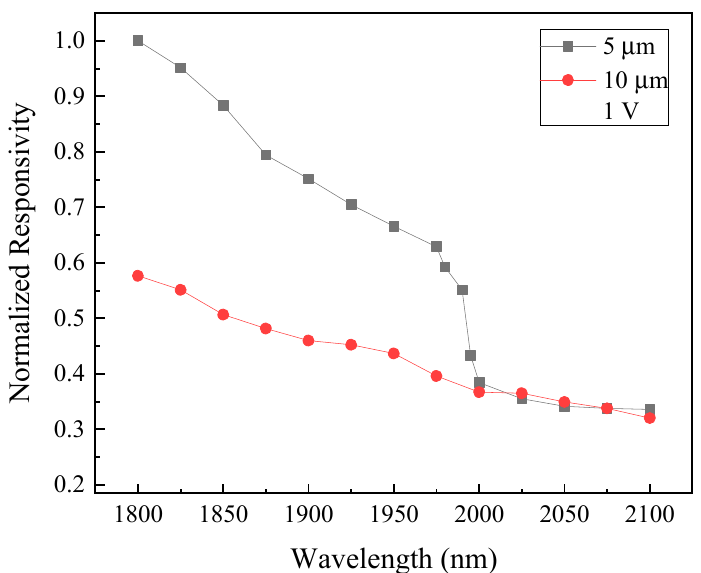
Figure 18. The normalized spectral responsivity of the GeSn MSM photodetector with AR layer and DBR structure incorporated.